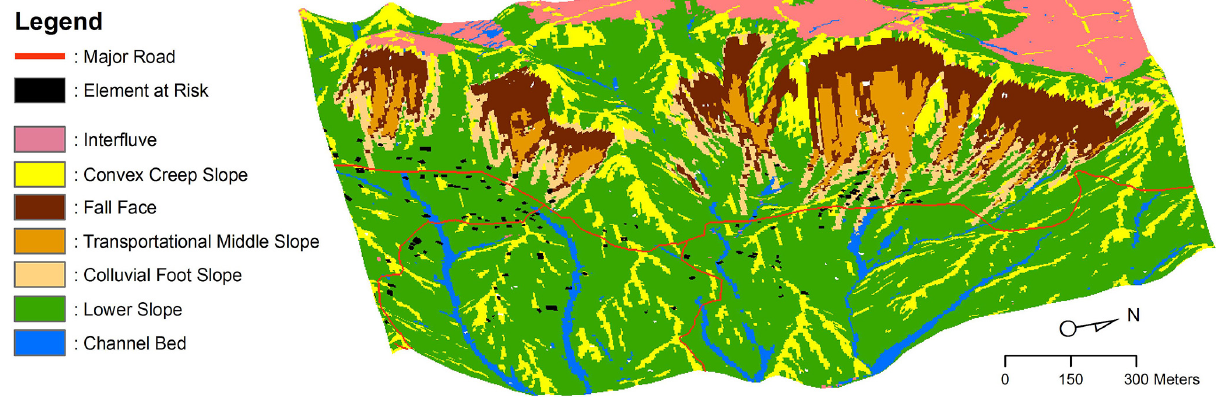
Figure 3. Generic landforms in Gunung Kelir.